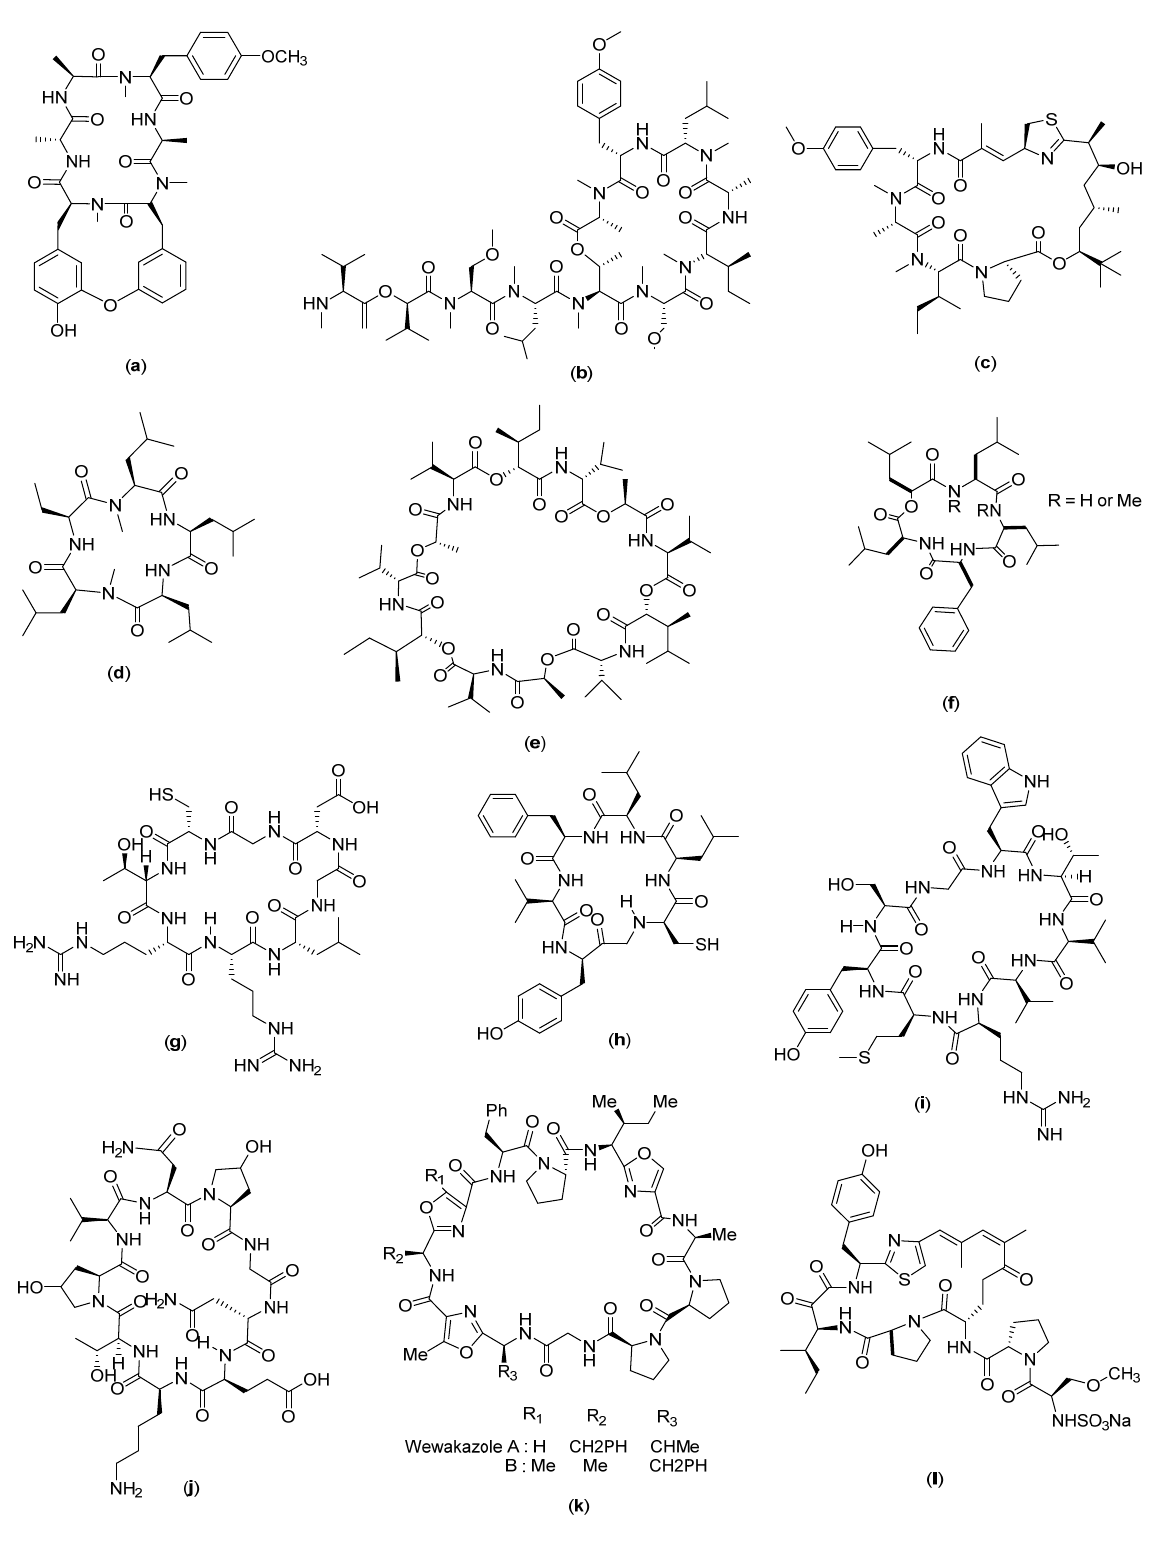
Figure 4. Structure of ( a ) RA-V; ( b ) Coibamide A; ( c ) Apratoxin A; ( d ) Galaxamide; ( e ) Bacillistatin 2; ( f ) Sansalvamide A; ( g ) Cyclosaplin; ( h ) Cyclo-CLLFVY; ( i ) Cyclo-SGWTVVRMY; ( j ) AFPep; ( k ) Wewakazole; and ( l ) Scleritodermin A. Sansalvamide (Figure 4f) is a cyclopentapeptide isolated from marine fungi of the genus Fusarium [25]. In a related study, 34 s-generation sansalvamide A (San A) deriva- tives were obtained. San A derivatives have shown anticancer properties towards colon,